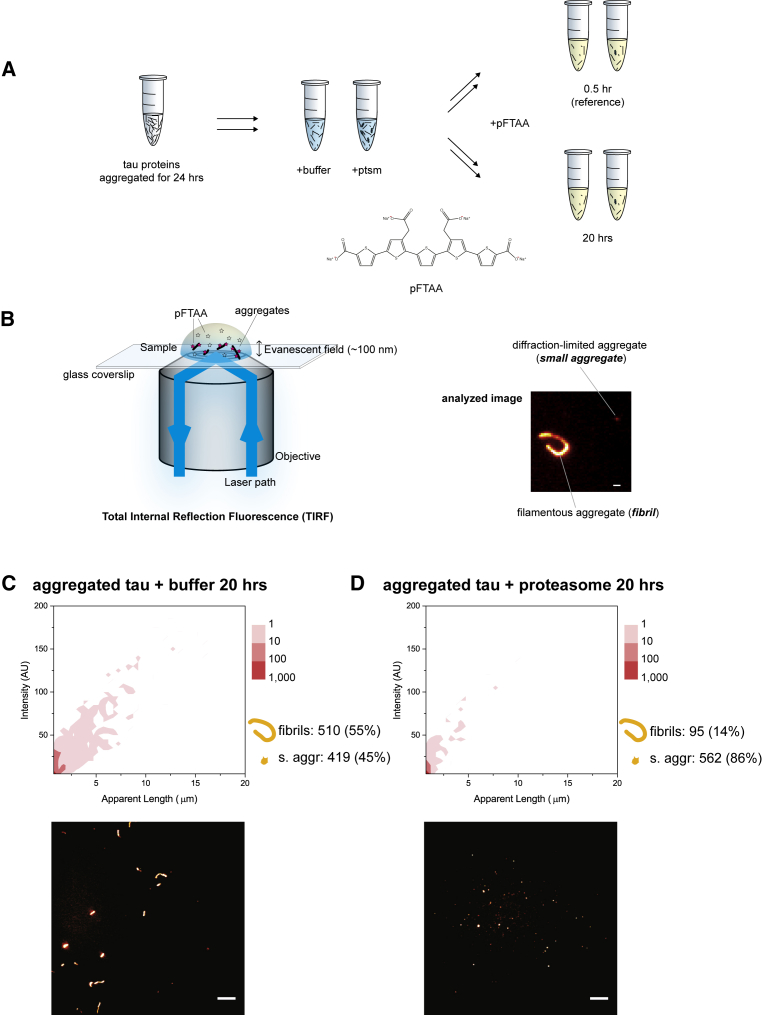
Imaging Fibrils with a Fluorescence TIRF Microscope(A) Recombinant full-length tau was aggregated for 24 h, and aliquots were taken and mixed with the proteasome in an ATP-containing proteasome buffer or with the buffer only as a control. After 0.5 h (starting reference) and 20 h of incubation, each reaction was diluted in an imaging buffer containing pFTAA. The chemical structure of pFTAA, which binds amyloid structures, is shown.(B) Samples were placed on a glass coverslip, excited with a 488 nm laser, and imaged on a custom-built TIRF microscope (see also Figure S3). A typical fibril (length, >1 μm) and diffraction-limited small aggregate (length, <1 μm) are shown. The scale bar represents 1 μm.(C and D) A large amount of fibrils remained present after incubation with the buffer alone (C), whereas treatment with the proteasome holoenzyme resulted in loss of fibrils and an increase in small aggregate count (D; depicted next to the 2D plot). The length of aggregates is plotted against the fluorescence intensity of pFTAA; the frequency is color-coded in the 2D plots. A processed image from each reaction is shown below the respective plots. The scale bars represent 10 μm.Results of three biological repeats (n = 3) performed independently using different protein preparations of tau and proteasome were combined into each plot. The SD between repeats was less than 20% in our TIRF experiments.